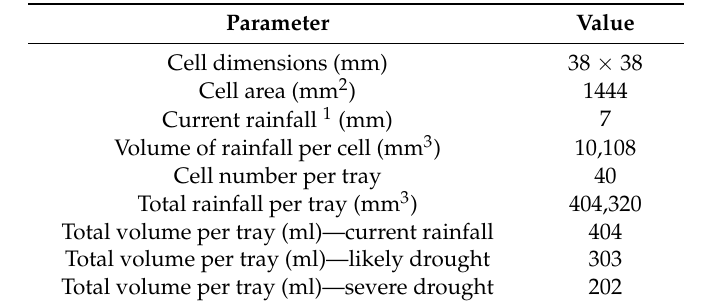
Table A1. Calculation for fortnightly watering volume for climate treatments. Volumes were reduced proportionally to account for plants removed during